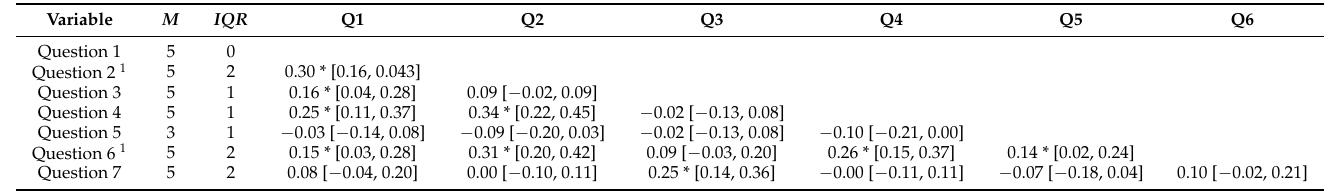
Table 3. NPAQ question agreement: Spearman correlation coefficients and 95% confidence intervals.